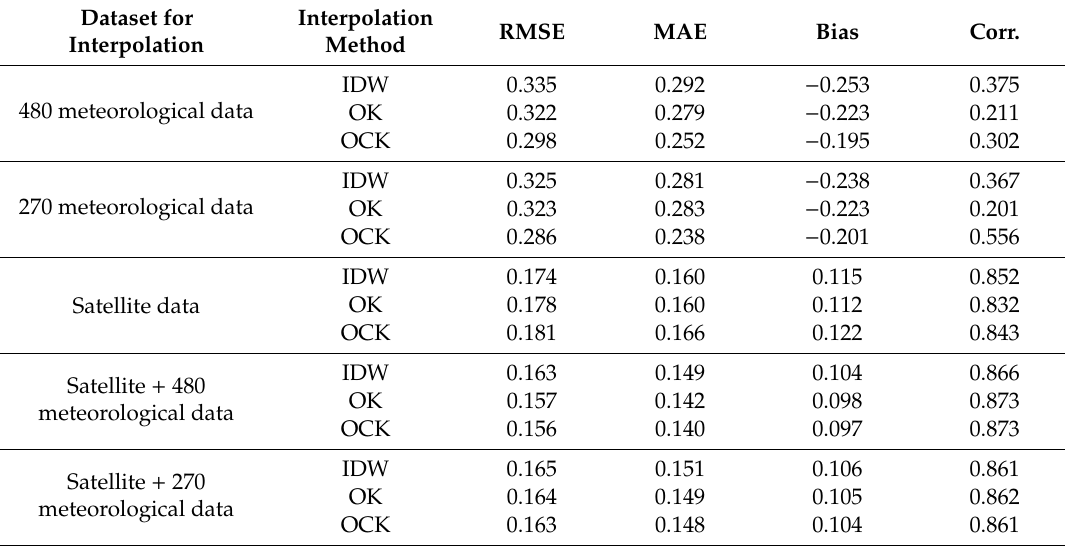
Table 5. Statistics of the comparison between buoy-derived Weibull shape parameter (k) data and interpolated Weibull k data at a height of 10